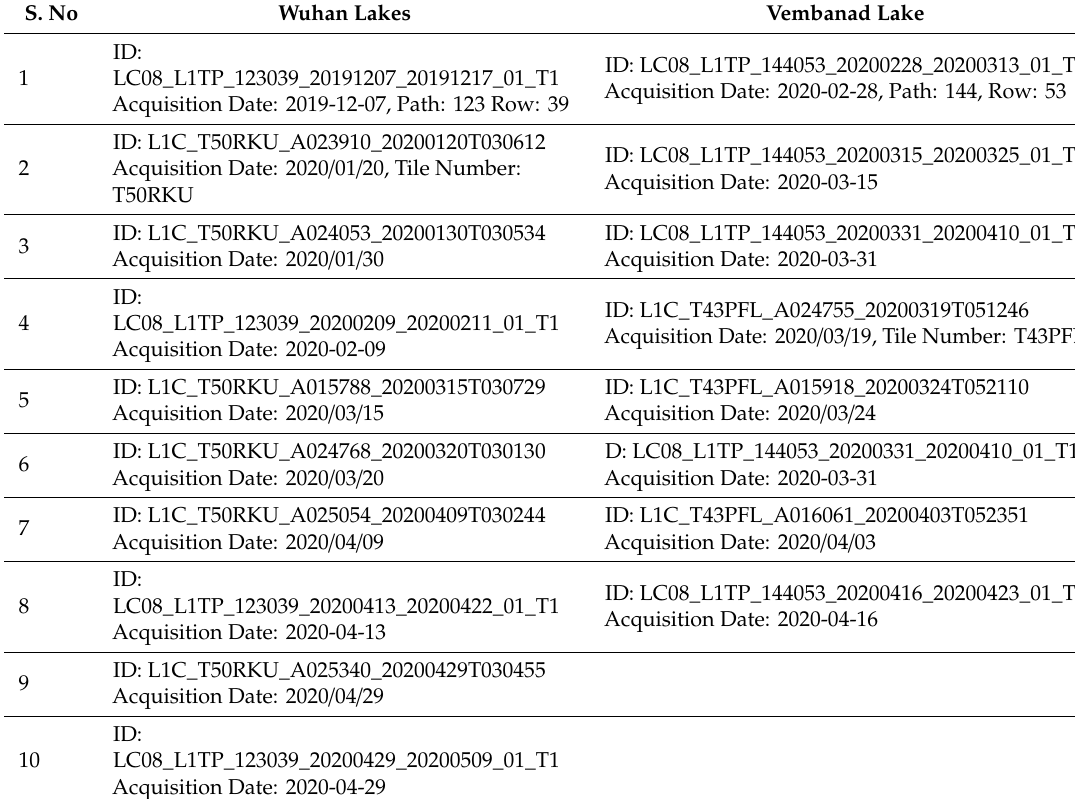
Table 1. Details of the satellite images used for mapping chlorophyll- a (Chl- a ) before and during